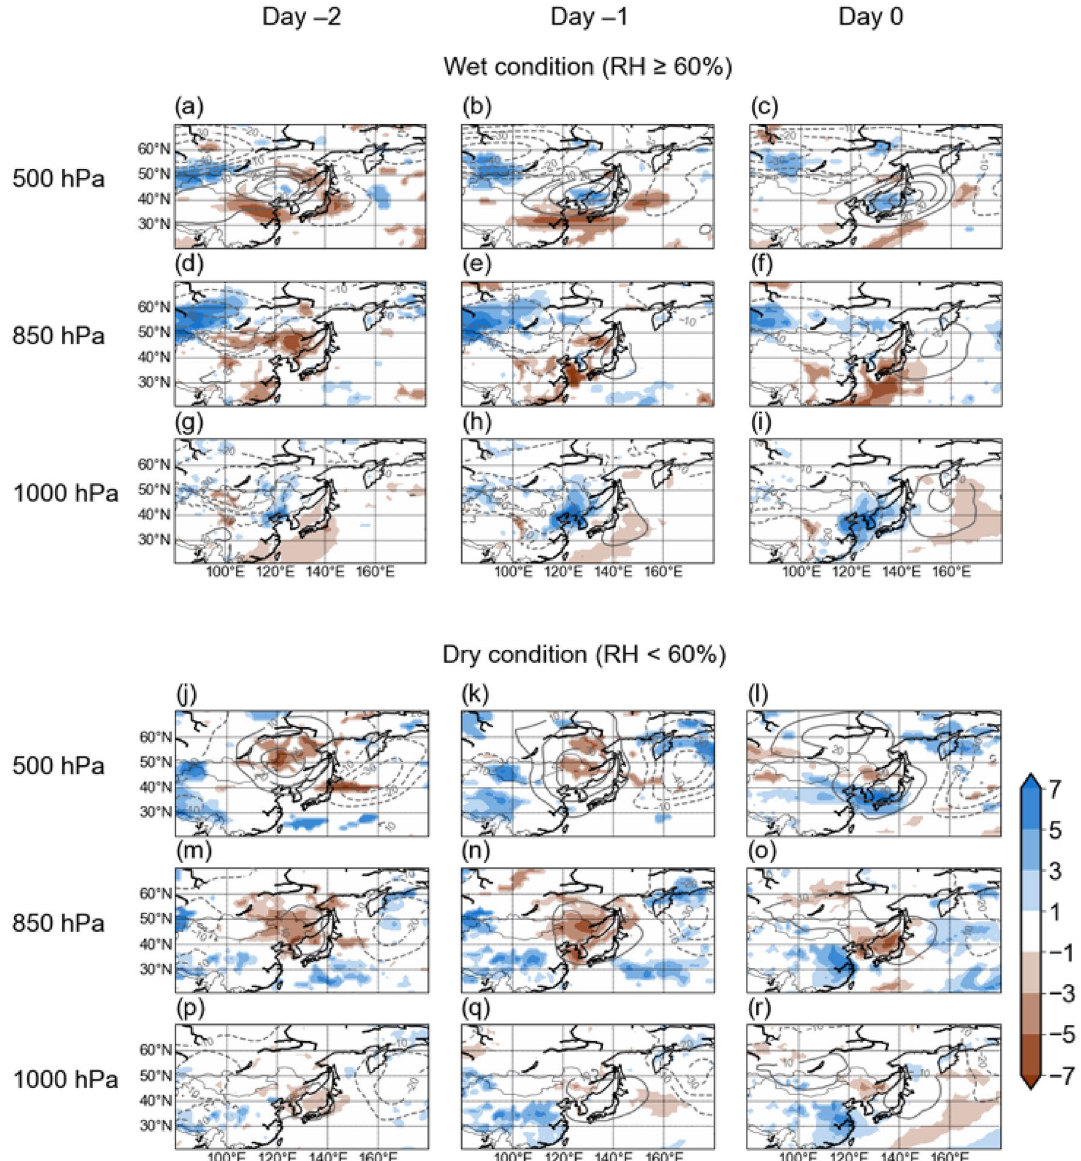
2.5 episodes under wet (upper panel) and dry (lower panel) condition in Day-2, Day-1, and Day 0 of high-PM 2.5 episodes. The anomalies were calculated against the daily climatology to remove seasonality of meteorological variables. Only statistically significant anomalies in RH at the 90% confidence level are shown as color